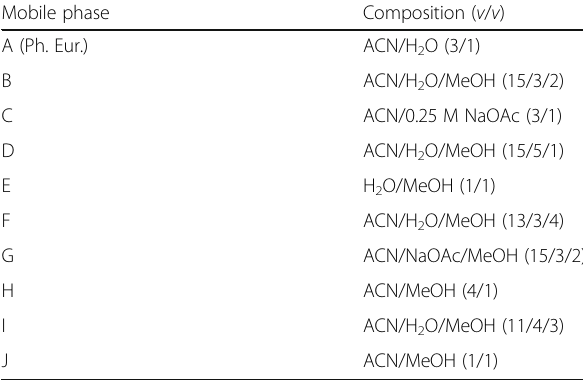
Table 1 Composition of the tested mobile phases Mobile